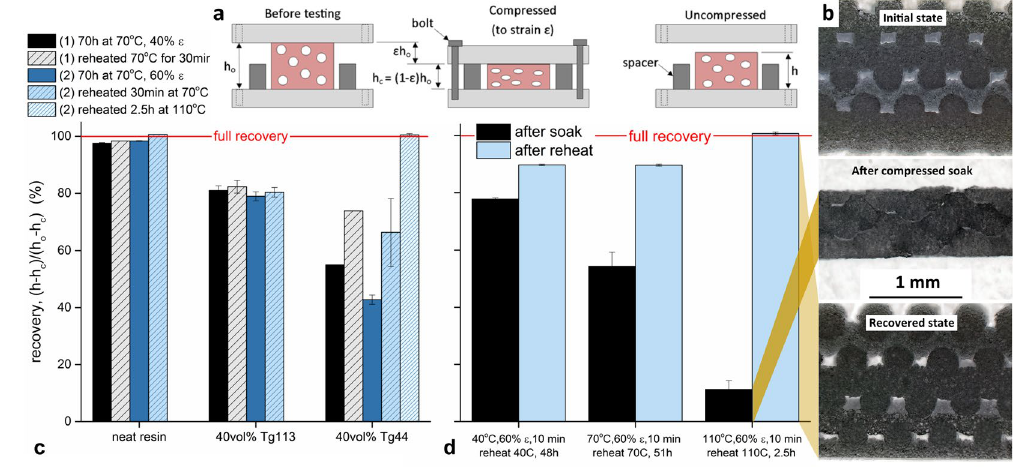
Figure 3. ( a ) Labeled schematic depicting the shape memory experiment, ( b ) optical microscopy images showing cross-sectional views of a printed structure with T g 44 microballoons at different stages of the shape memory experiment, ( c ) shape memory behavior following thermal soak under compressive strain at 70 °C for 70 hours, and ( d ) time dependent recovery behavior in the T g 44 microballoon prints near T g and above T g